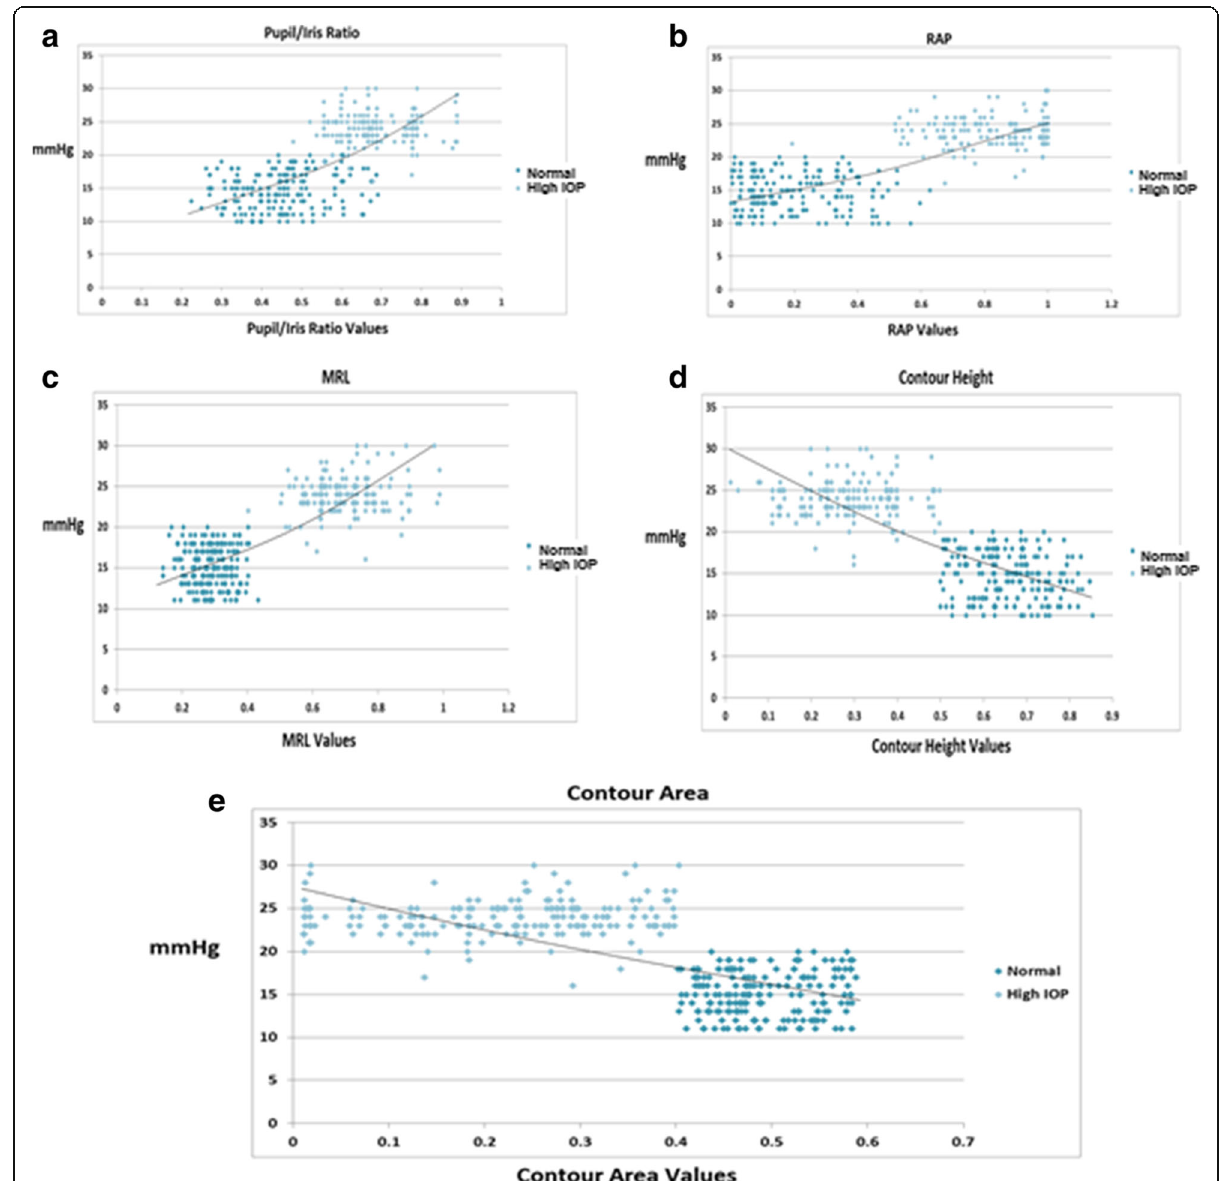
Fig. 14 Correlation between the five features and IOP in millimeter of mercury. a Pupil/iris ratio feature. b Red area percentage feature. c Mean redness level feature. d Contour height feature. e Contour area feature